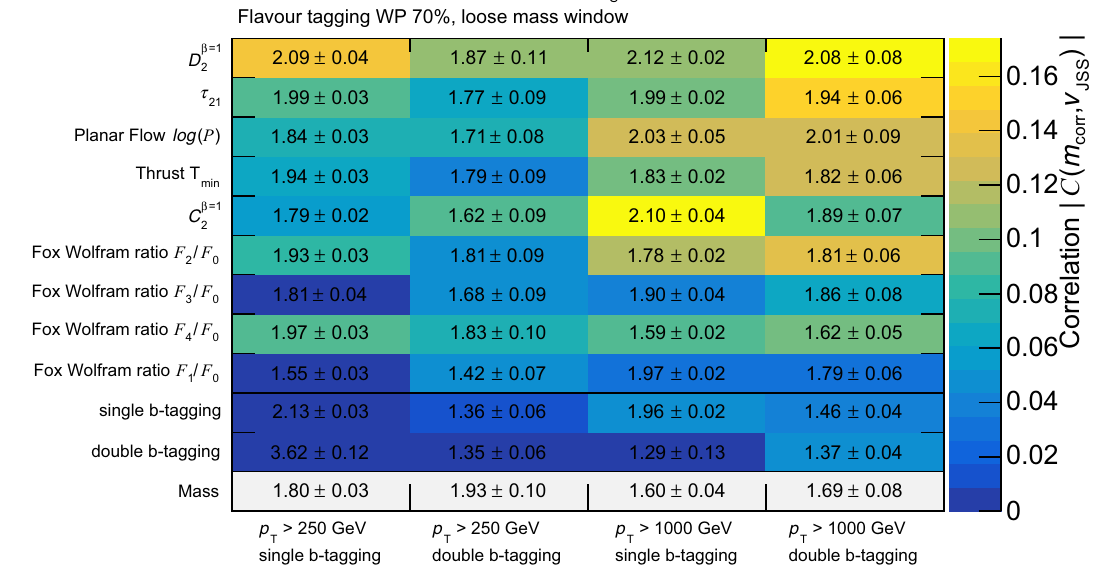
Fig. 11 Multijet background rejection at 80% signal efficiency ( ε S = 80%) for a variety of substructure variables using different benchmarks in terms of b -tagging strategy and transverse momentum range. The z - axis colour scale represents the absolute value of the linear-correlation